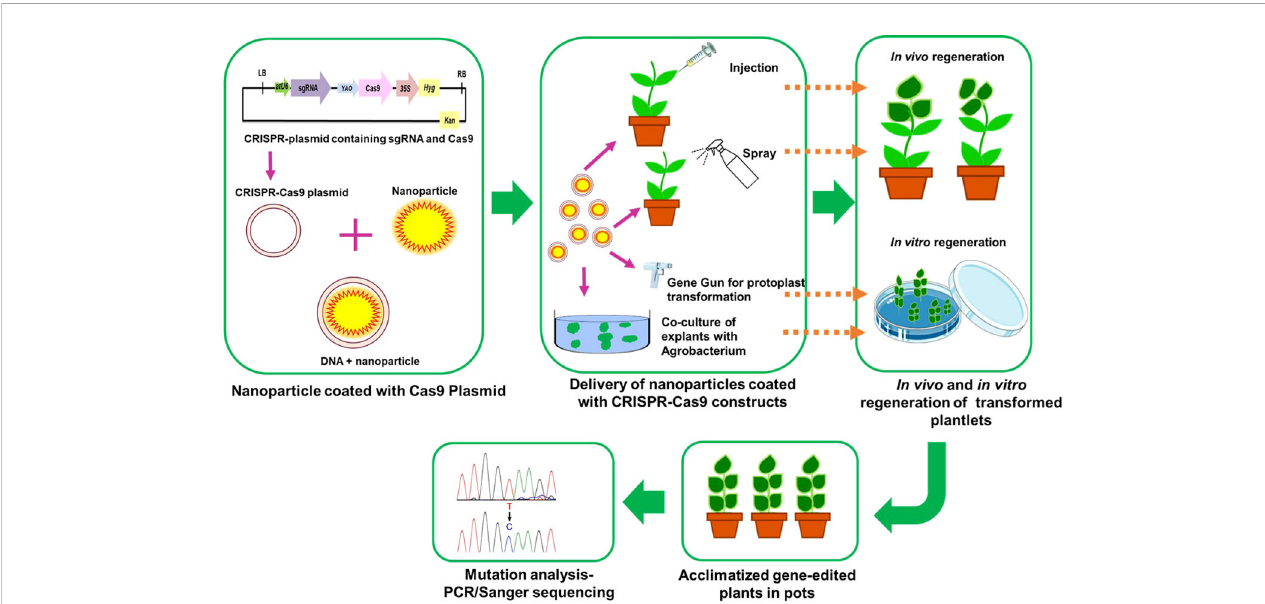
FIGURE 5 A schematic representation of nano-particle mediated delivery of CRISPR-Cas9 construct into